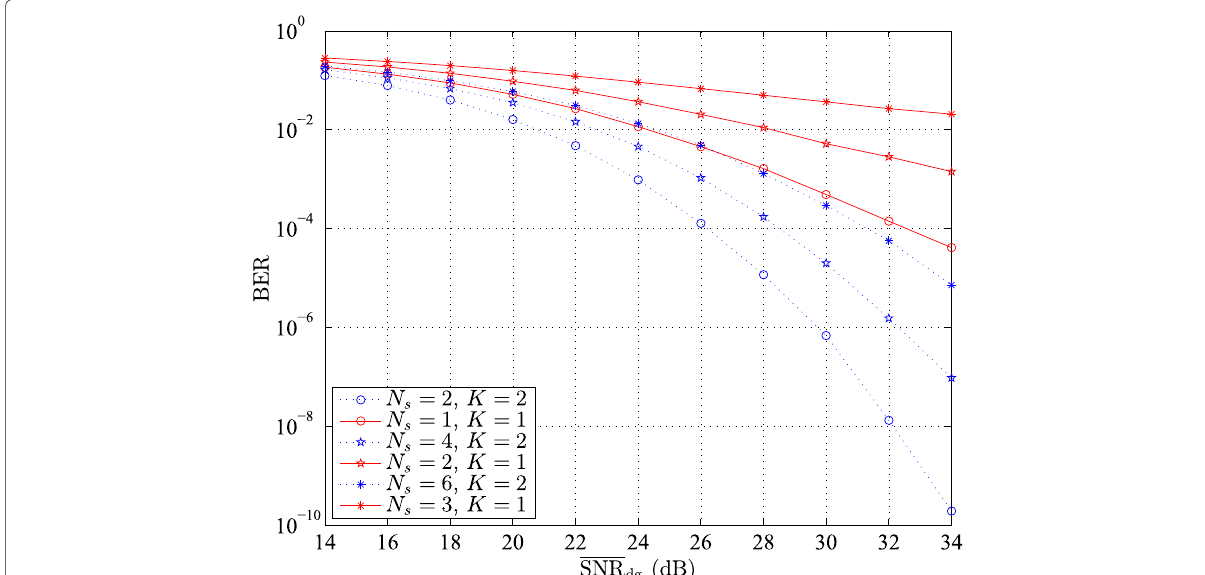
Fig. 5 BER versus designed SNR: comparison between distributed and co-located antenna array